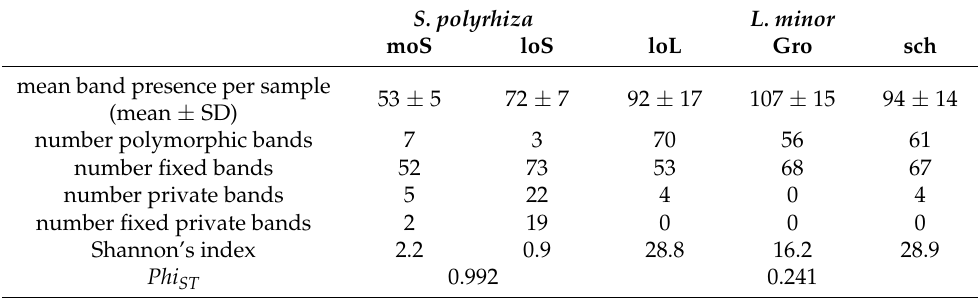
Table 1. Band statistics of AFLP analysis for the investigated ponds. lo = Lotschen, mo = Moscow, gro = Groeben, sch = Schloeben, S = Spirodela polyrhiza , L = Lemna minor , SD = standard deviation. S. polyrhiza L. minor